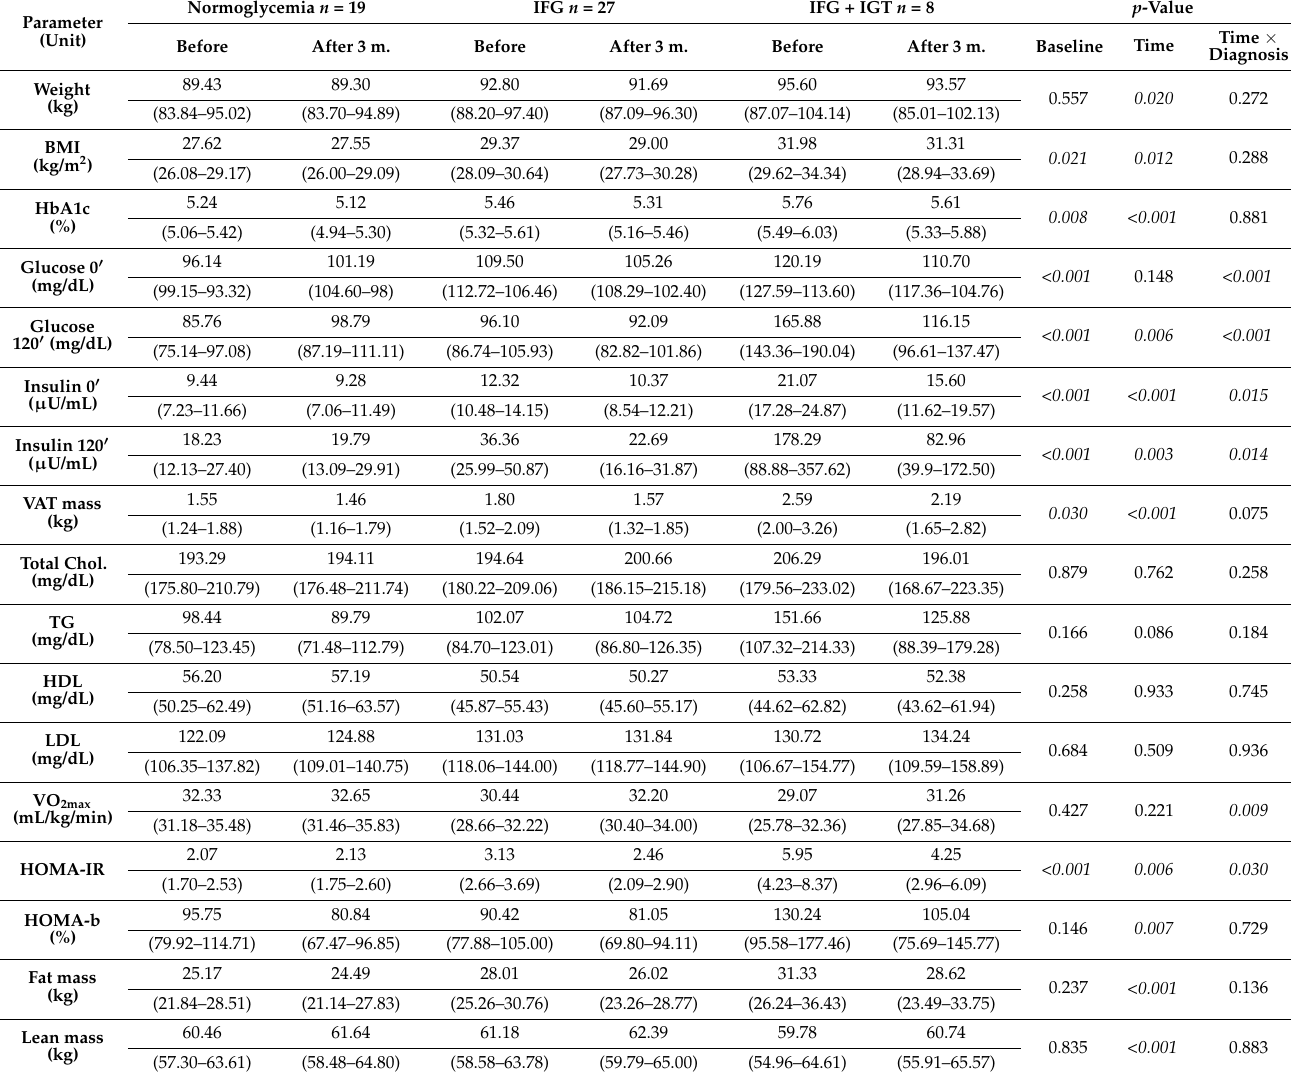
Table 2. Clinical characteristics of studied participants. Presented are mean values and interquartile ranges for each parameter. IFG-subjects with impaired fasting glucose and normal glucose tolerance; IFG+IGT–subjects with impaired fasting glucose and impaired glucose tolerance; BMI–body mass index; HbA1c-Haemoglobin A1c; VAT–visceral adipose tissue; TG–triglycerides; HDL-high-density lipoprotein cholesterol; LDL-low-density lipoprotein cholesterol; VO2max- maximal oxygen consumption; HOMA-IR-homeostatic model assessment for insulin resistance was calculated; HOMA- β - homeostatic model assessment of beta-cell function. Bold and Italic values denote statistical significance at the p < 0.05